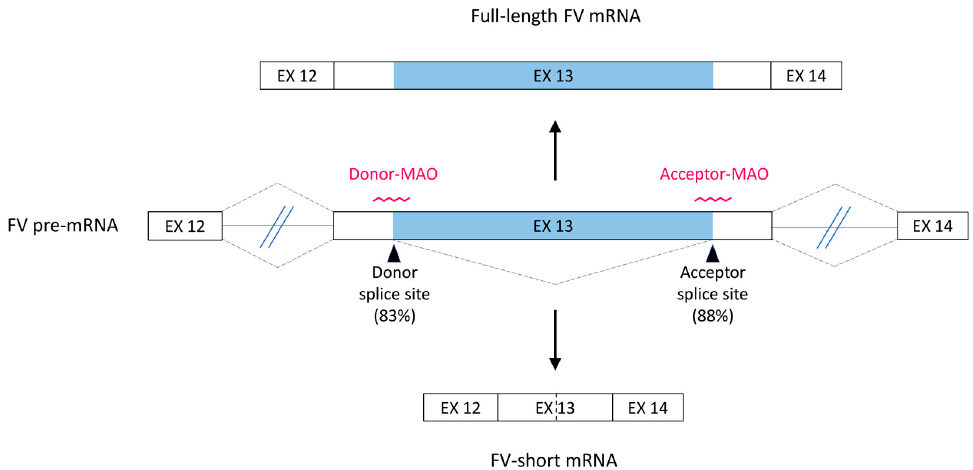
Figure 1. Alternative splicing of the F5 gene. Schematic representation of the F5 pre-mRNA region spanning exons 12–14. The large exon 13 contains an internal optional intron (light blue), which is usually retained in the mature mRNA (default full-length FV transcript, top), but occasionally spliced out (alternative FV-short transcript, bottom). The consensus scores for the FV-short-specific donor and acceptor splice sites are reported in brackets and the morpholino antisense oligonucleotides (MAOs) designed to target these sites are shown. EX: exon.